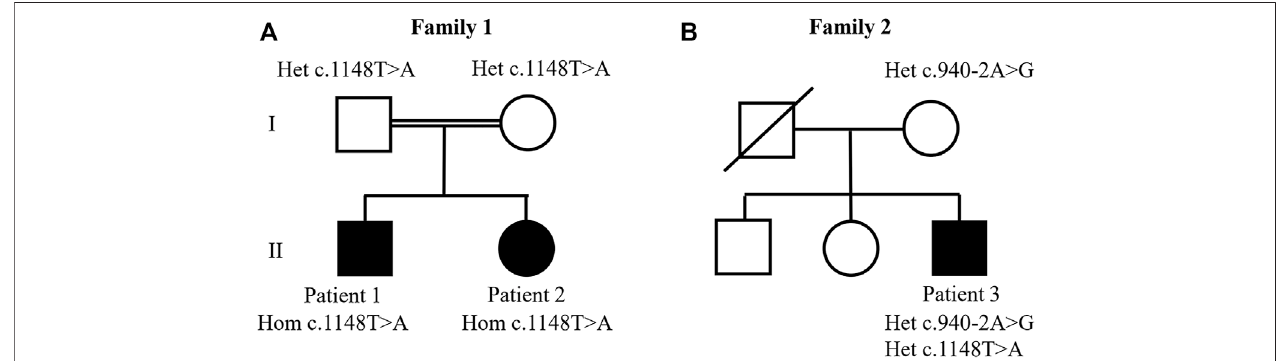
FIGURE 1 | Studied families ’ pedigrees. (A) Family 1: whole exome sequencing analysis identi fi ed the homozygous c.1148T > A. p.(Ile383Asn) variant in patients 1 and 2. (B) Family 2: compound heterozygous variants were identi fi ed in patient 3 at positions c.1148T > A. p.(Ile383Asn) and c. 940-2A >